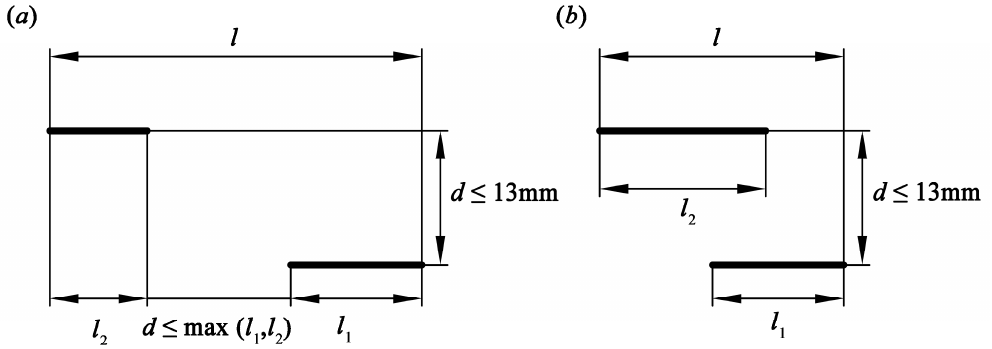
Figure 12. Method for simplification of double parallel cracks proposed by ASME: ( a ) nonoverlapping cracks and ( b ) overlapping cracks.